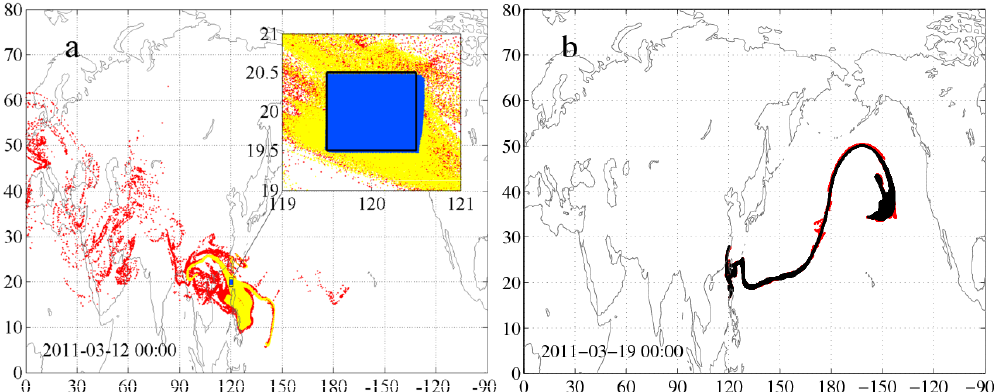
Figure 1. Forward (black) and backward (colored) pollutant clouds emitted instantaneously and consisting of n 0 = 1.25 × 10 5 particles at ( a ) t = 0 and ( b ) t = 7 days. The forward pollutant cloud is initiated on 12 March 2011 at 00 UTC at 120 ◦ E, 20 ◦ N, 500 hPa in a 1 ◦ × 1 ◦ × 100 hPa cuboid beyond Indonesia. Colored dots denote the location of the particles whose backward simulation started at time t b = 2 days (blue), t b = 7 days (yellow) and t b = 9 days (red), respectively. In the inset of panel (a) instead of black dots the initial position of the particles is illustrated by a black rectangular frame. This simulation is an element of the global study in Section 6.